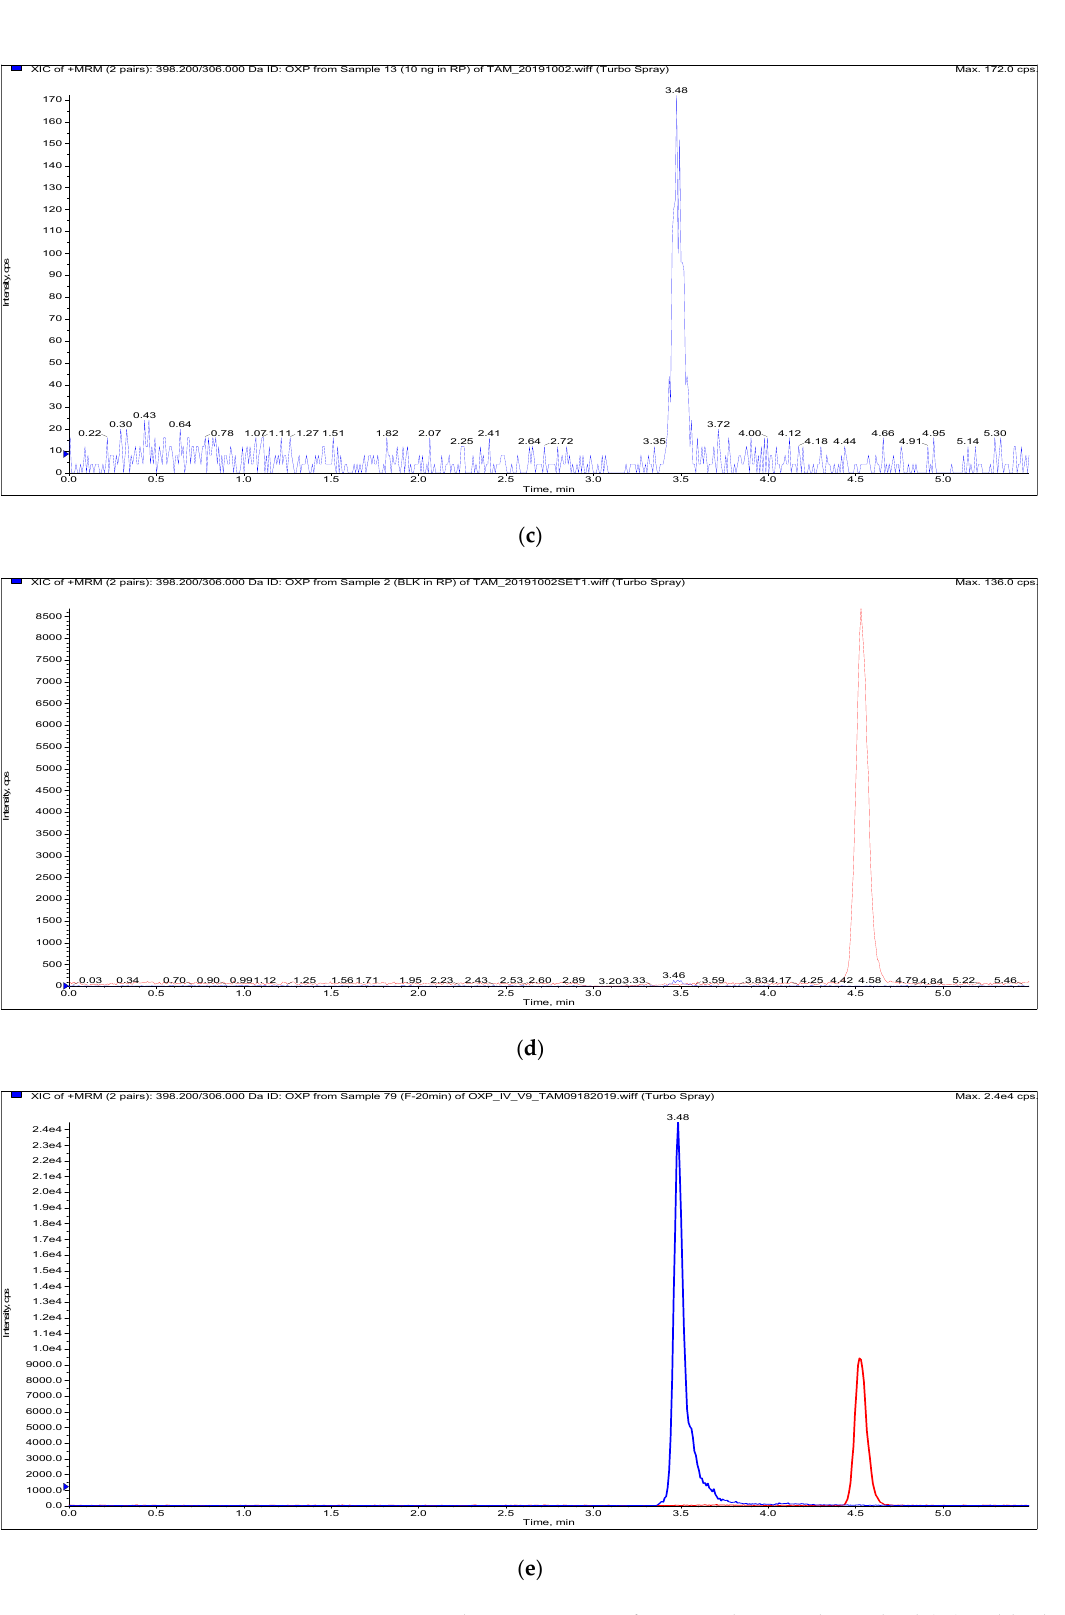
Figure 3. Representative chromatograms of OXP and internal standard (IS) in blank and spiked rat plasma: ( a ) blank plasma, ( b ) OXP spiked in plasma at the lower limit of detection (5 ng/mL), ( c ) OXP spiked in plasma at the lower limit of quantification (10 ng/mL), ( d ) blank plasma spiked with IS, ( e ) rat plasma sample at 20 min after 25 mg/kg body weight (BW) intravenous (IV) administration. OXP transition depicted in blue and IS transition depicted in red.